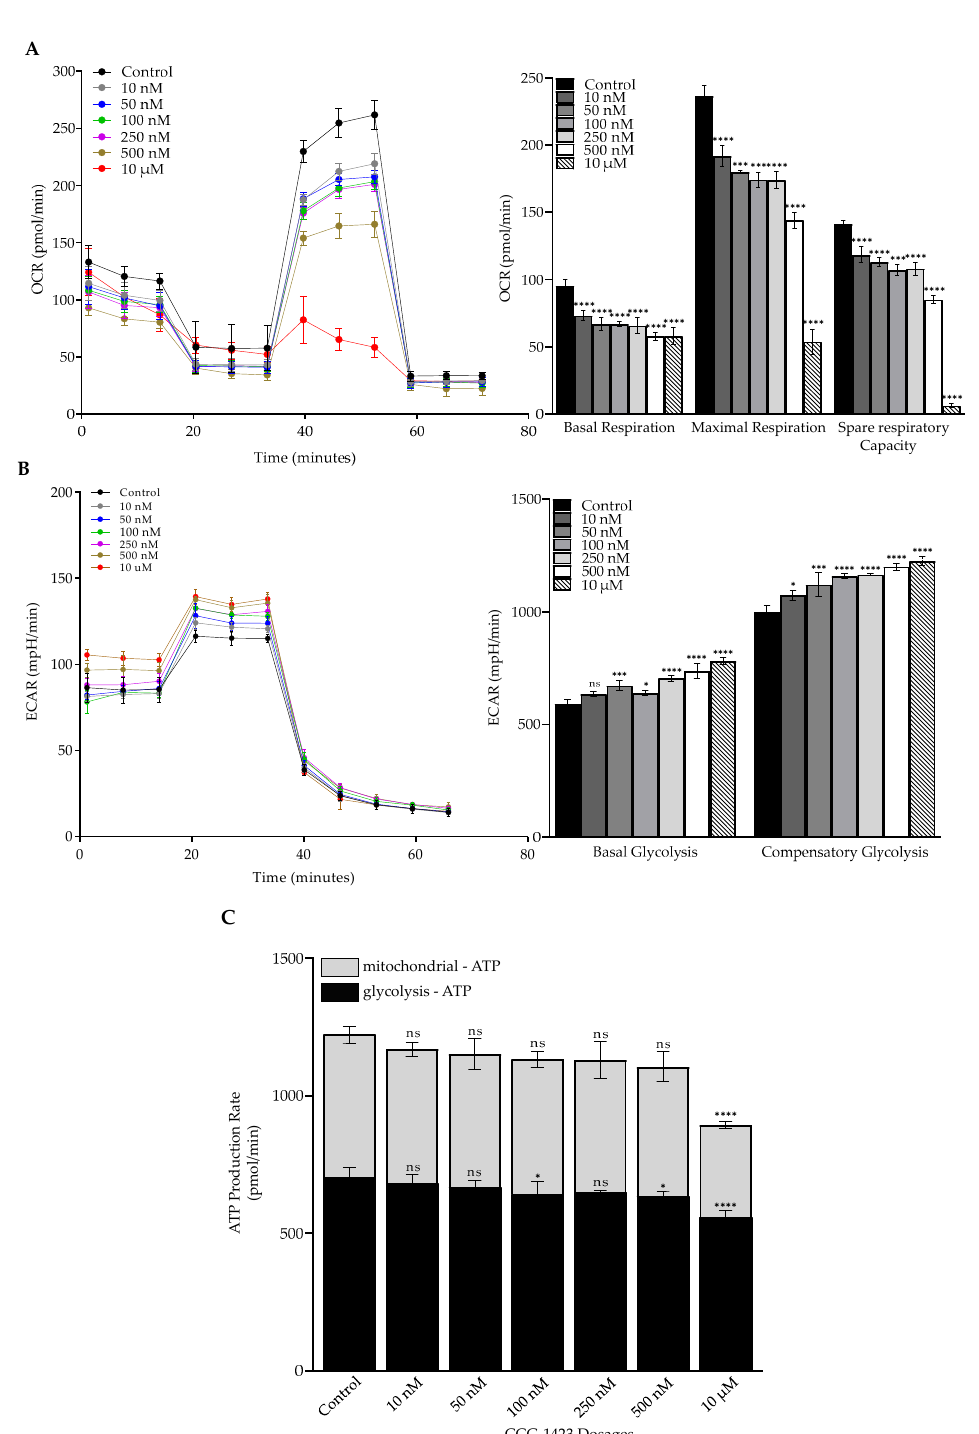
Figure 5. Mitochondria functional analysis of oxygen consumption rate, extracellular acidification rate, and total ATP production. ( A ) OCR and basal respiration, maximum respiration, and spare respiratory capacity in CCG-1423 treated cells with different dosages. OCR was repressed in a dose dependent manner upon the treatment of CCG-1423 in C2C12 cells. ( B ) CCG-1423 upregulated the ECAR in a dose dependent manner. ( C ) Total ATP production was decreased in both mechanisms of oxidative phosphorylation (mitochondrial-ATP) and glycolysis (glycolysis-ATP). * p < 0.05, *** p < 0.001, **** p < 0.0001, ns: p > 0.05 ( n =